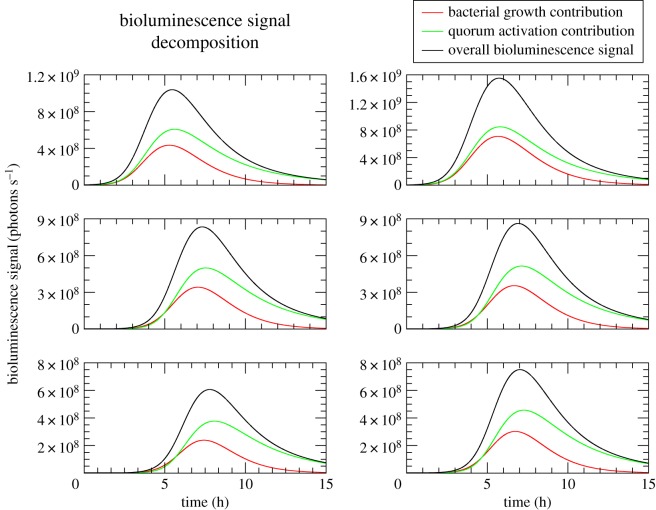
Decomposition of the overall bioluminescence signal p(t) (black) from biophysical model fits in colony growth g(t) (red) and quorum activation h(t) (green) contributions. Different panels show signal decomposition for the fits of the different experimental curves measured in [30].